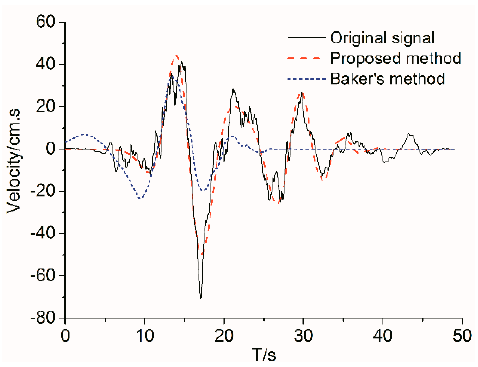
12 of 18 Figure 10. The extracted dominant pulse components embedded in 𝑺 (cid:2968) at station TCU101: ( a ) p (cid:2869) ,